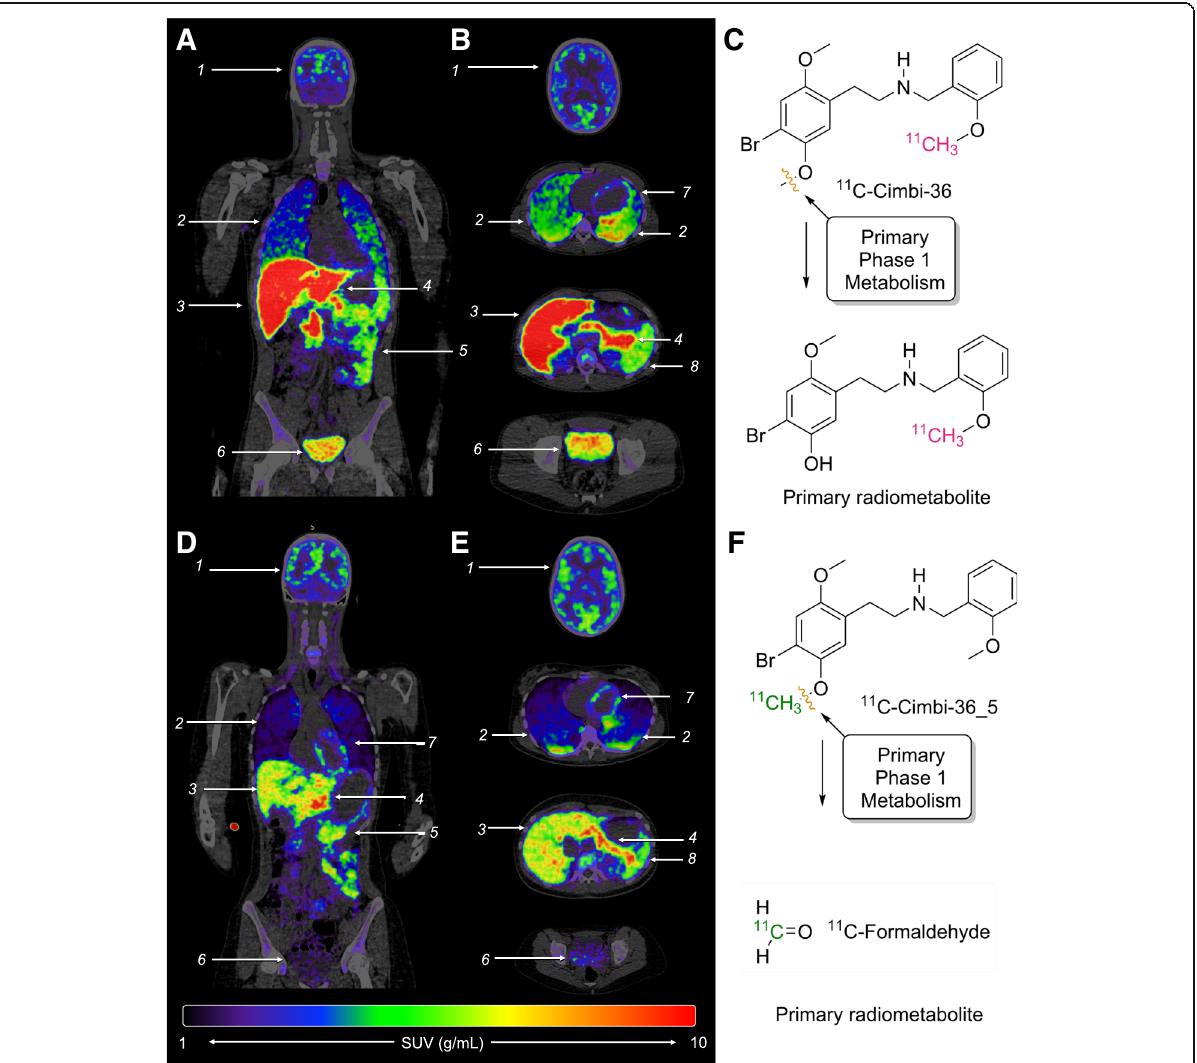
Fig. 1 Coronal and horizontal PET/CT fused images of 11 C-Cimbi-36 ( a , b ) and 11 C-Cimbi-36_5 ( d , e ) 40 min into the scan. Brain (1), lungs (2), liver (3), pancreas (4), small intestines (5), urinary bladder (6), heart wall (7), spleen (8). Primary phase 1 metabolic route resulting in different radiometabolites for 11 C-Cimbi-36 ( c ) and 11 C-Cimbi-36_5 ( f